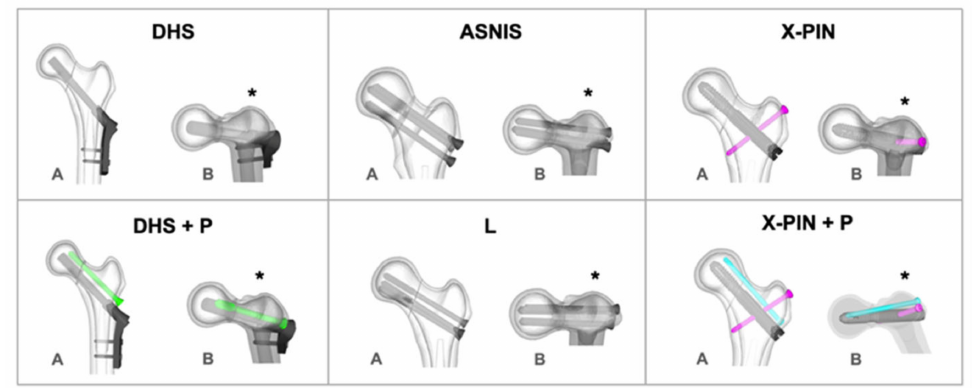
Figure 3. Illustrations of the included synthesis models. (*): posterior region; ( A ) coronal view of the proximal femur; ( B ) axial view of the proximal femur.